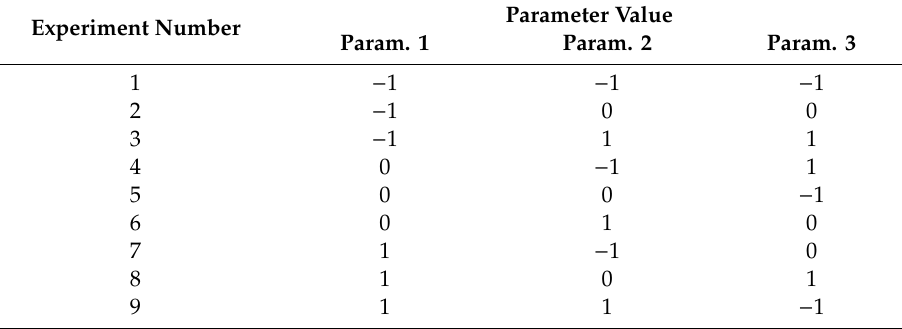
Table 6. The three-parameter / three-level Taguchi orthogonal